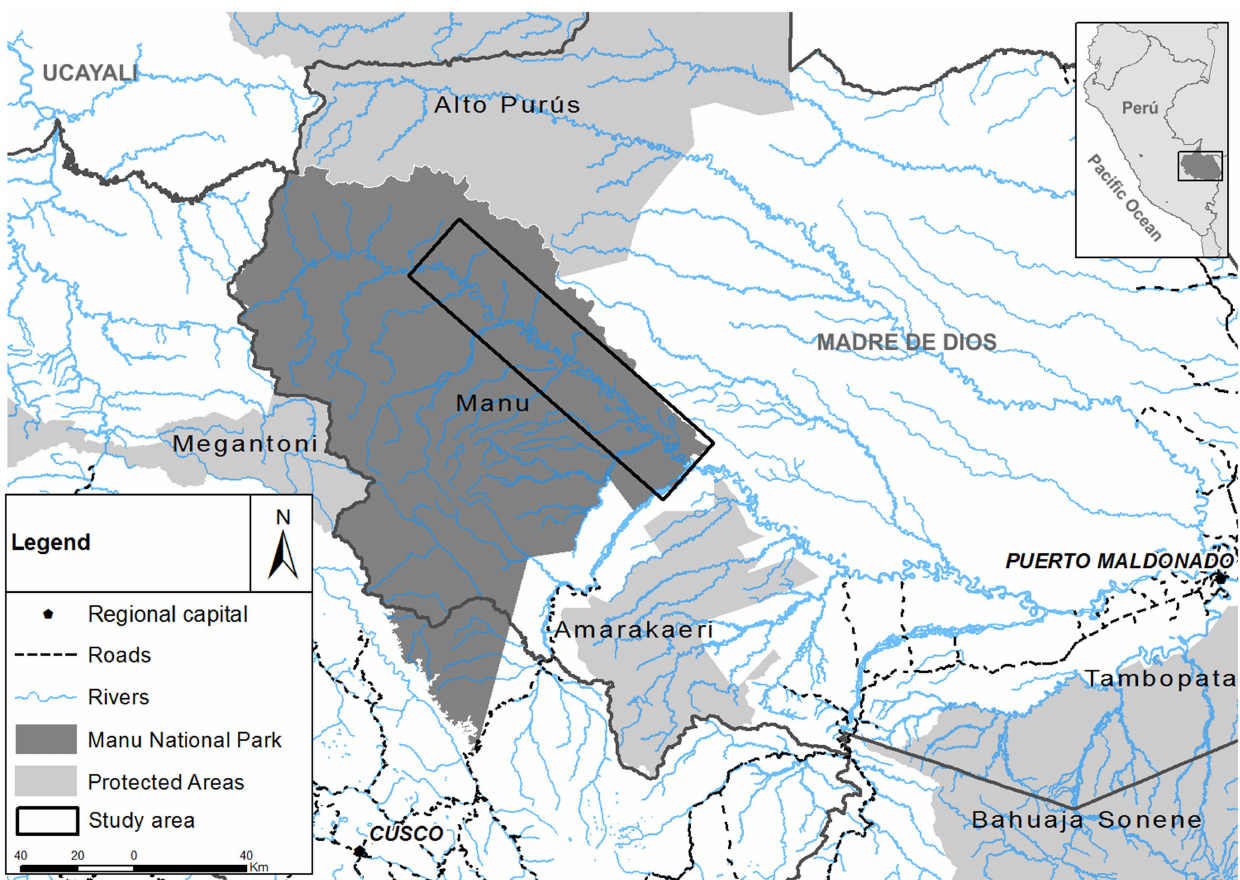
Figure 1. The study area (large black rectangle), Manu National Park, south-eastern Peru.